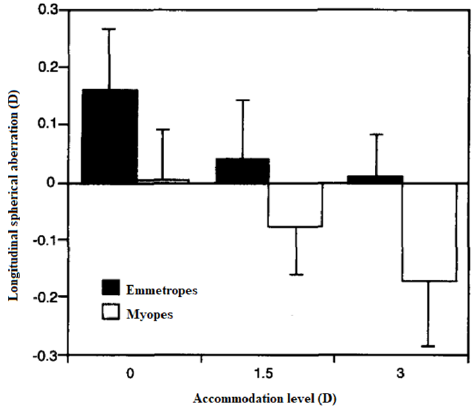
Figure 5. Longitudinal spherical aberration in different accommodation levels for emmetropes and myopes. Adapted with permission from Ref. [1] “Monochromatic aberrations and myopia” by M. Collins, C. Wildsoet, D. Atchison, 1995, Vision Res ., Volume 35(9), 1162, Copyright @2002, Elsevier. (https://doi.org/10.1016/0042-6989(94)00236-f).